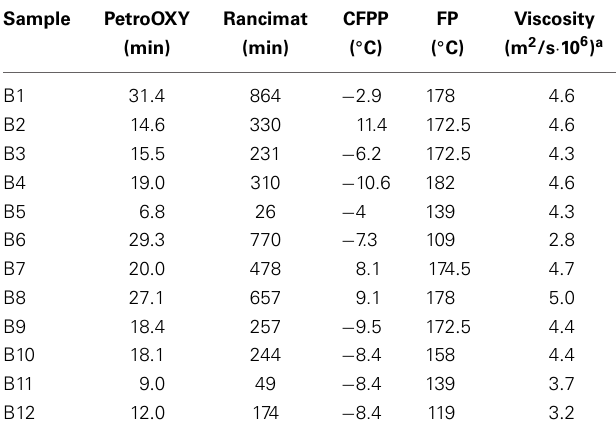
Table 3 | Physicochemical properties of the biodiesel and biodiesel blends produced.